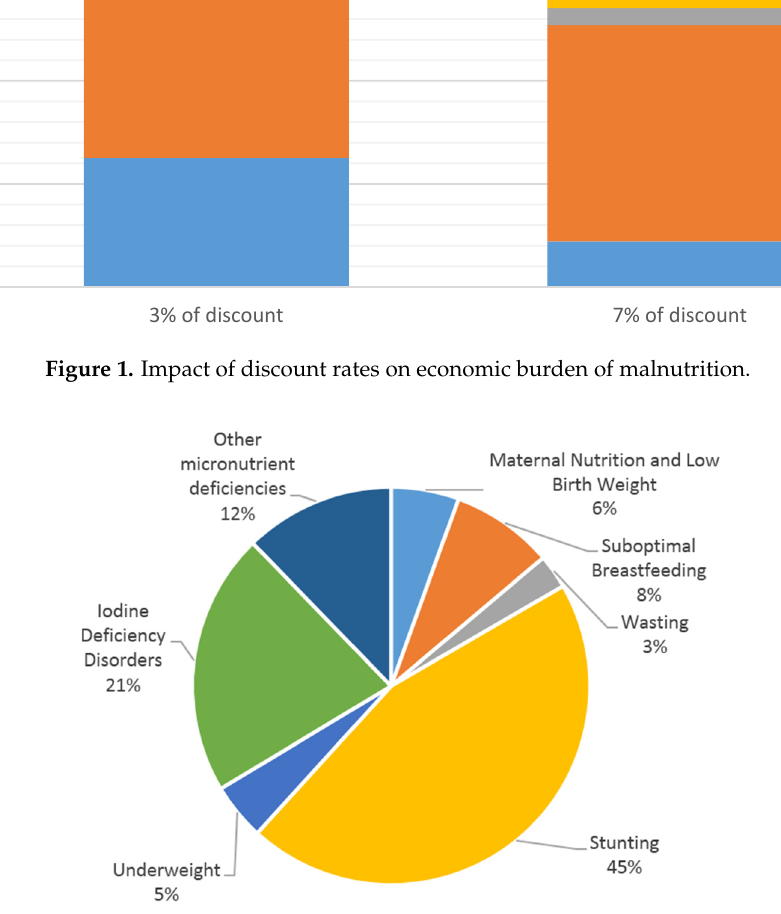
Figure 2. Impact on the total economic burden of malnutrition (using 3% discount rate). Table 5. Mortality among Children under 5 Years of Age associated with Key Indicators of Malnutrition.